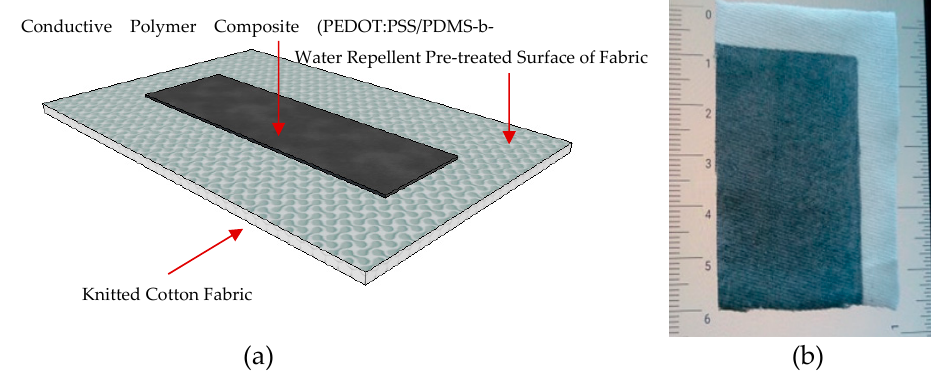
Figure 4. ( a ) Schematic design of the conductive textile fabric;( b )actual conductive textile fabric.